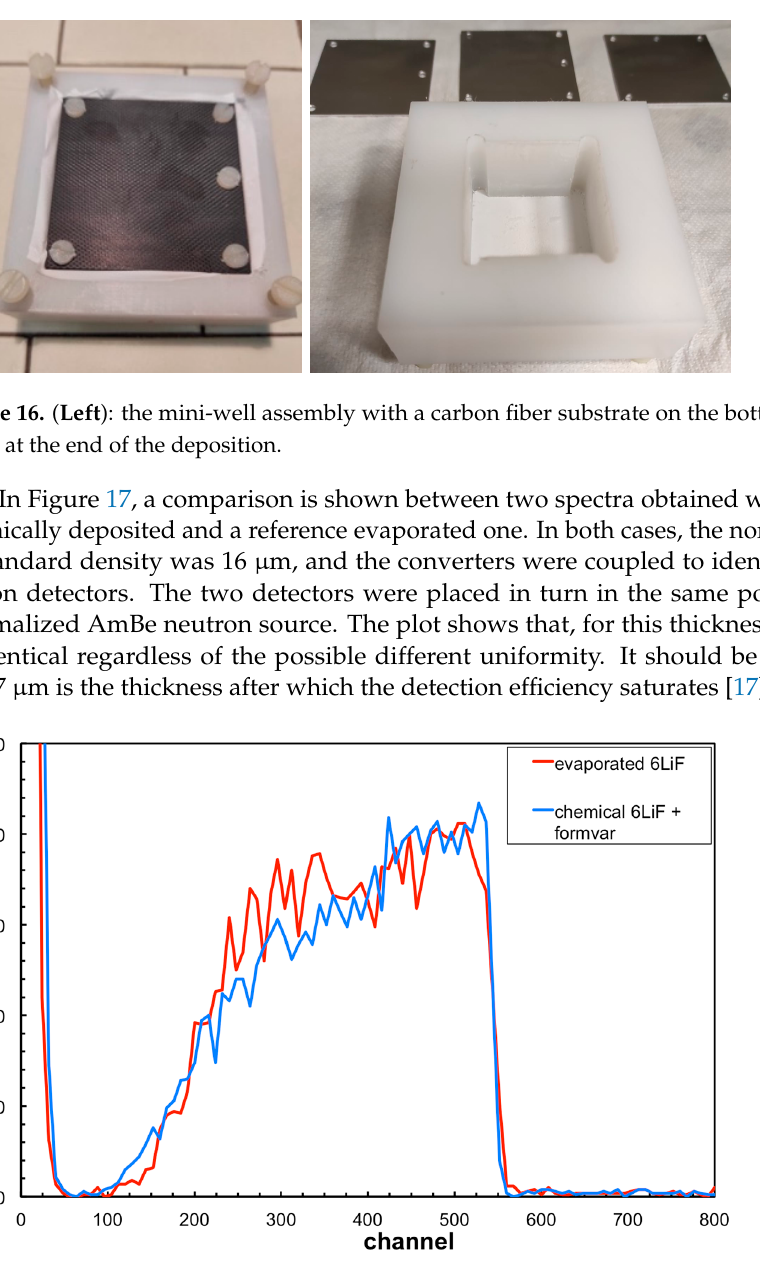
Figure 15. Pictorial scheme summarizing the phases of the chemical deposition technique for the production of a 6 LiF neutron converter layer onto a suitable substrate.